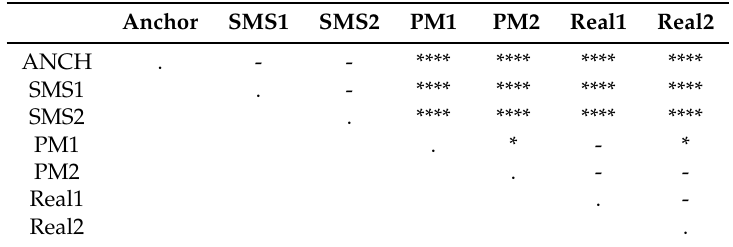
Table 5. The effect of different samples for a baseball bat (**** ⇒ p < 0.0001, *** ⇒ p < 0.001, ** ⇒ p < 0.01, * ⇒ p < 0.05, - ⇒ p ≥ 0.05). SMS, spectral modelling synthesis; PM, physical model; Real, recorded sample.